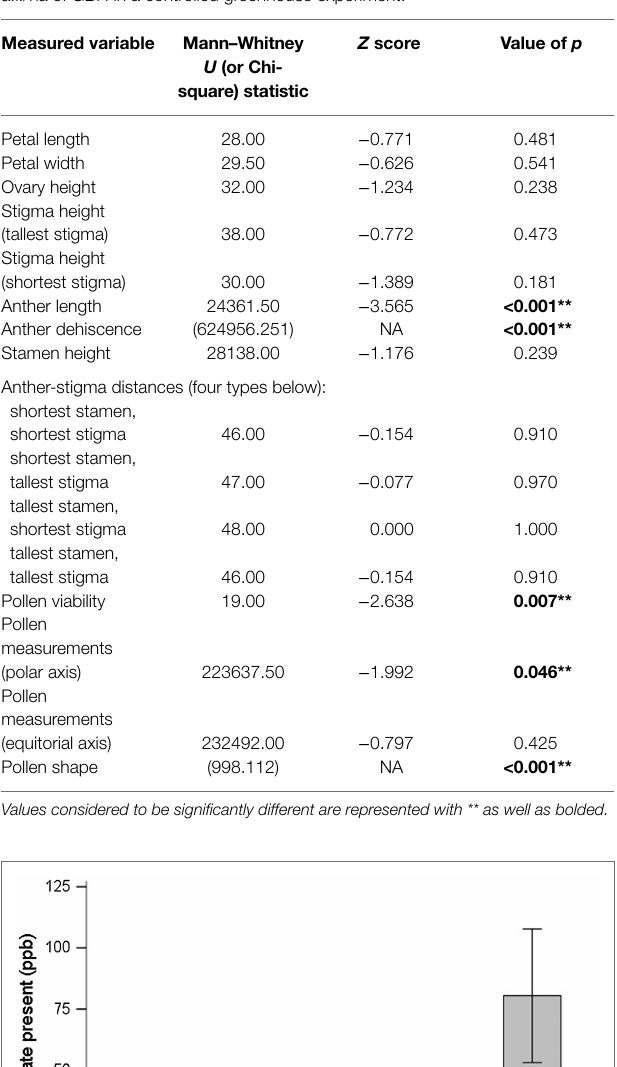
TABLE 4 | Summary of values of p resulting from Mann–Whitney U and Chi-square tests conducted to determine significant differences between the characteristics of control R. acicularis flowers and those treated with 0.45 kg a.i./ha of GBH in a controlled greenhouse experiment.